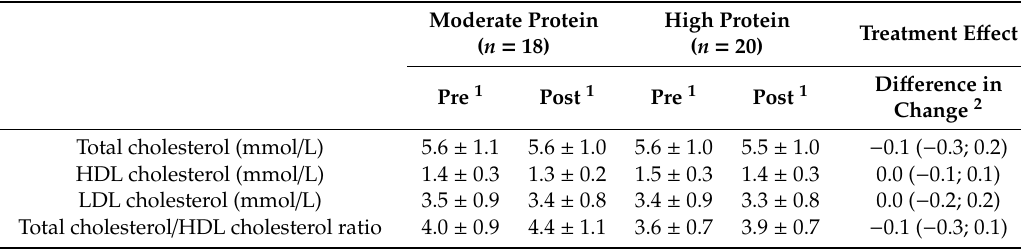
Table 2. Metabolic risk markers at pre- and post-respiration chamber time points with a moderate- and high-protein